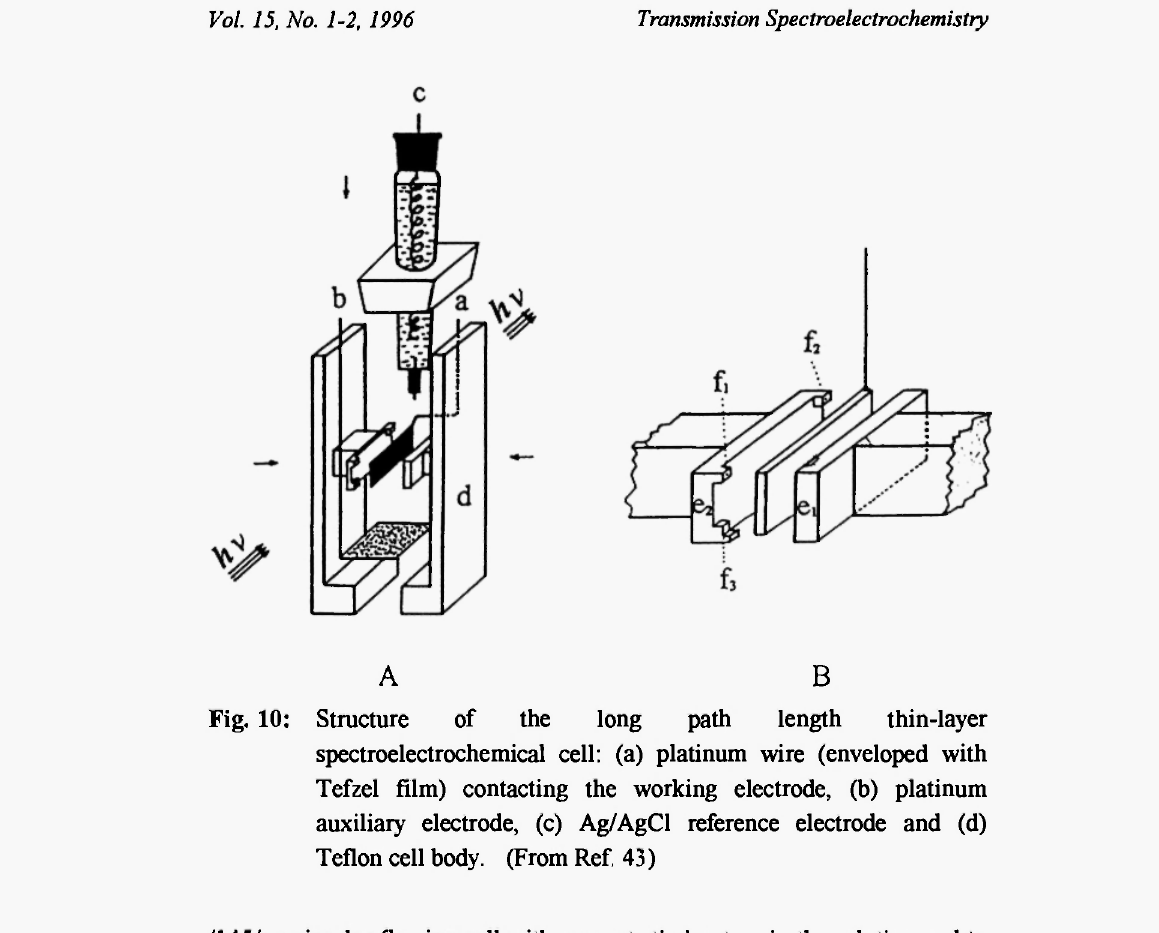
A Β Fig. 10: Structure of the long path length thin-layer spectroelectrochemical cell: (a) platinum wire (enveloped with Tefzel film) contacting the working electrode, (b) platinum auxiliary electrode, (c) Ag/AgCl reference electrode and (d) Teflon cell body. (From Ref.